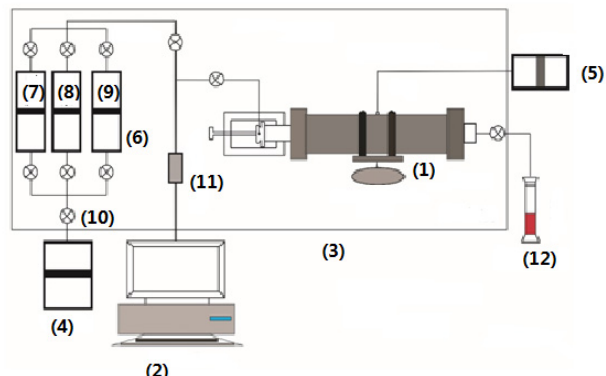
Figure 3. Schematic of core filtration experimental setup: ( 1 ) core holder; ( 2 ) computer; ( 3 ) oven; ( 4 ) constant speed pump; ( 5 ) manual pump; ( 6 ) container; ( 7 ) oil sample; ( 8 ) brine; ( 9 ) VES solution; ( 10 ) six-way valve; ( 11 ) pressure sensor; ( 12 ) cylinder.